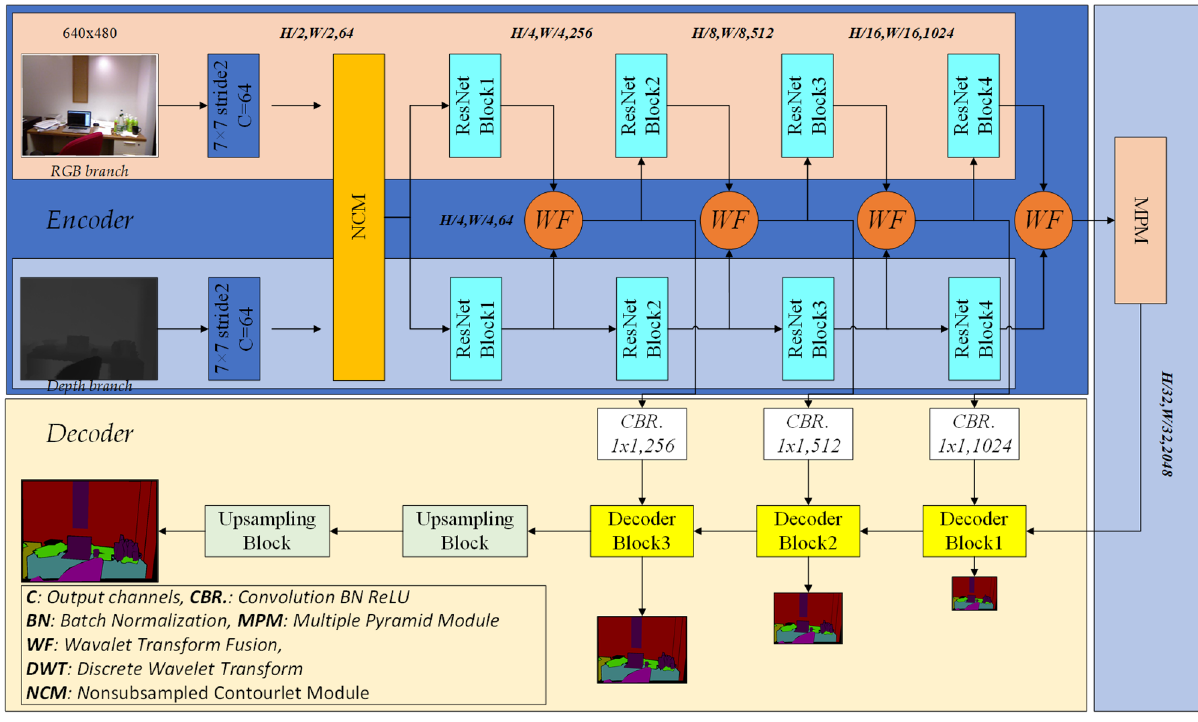
Figure 1. Network structure of